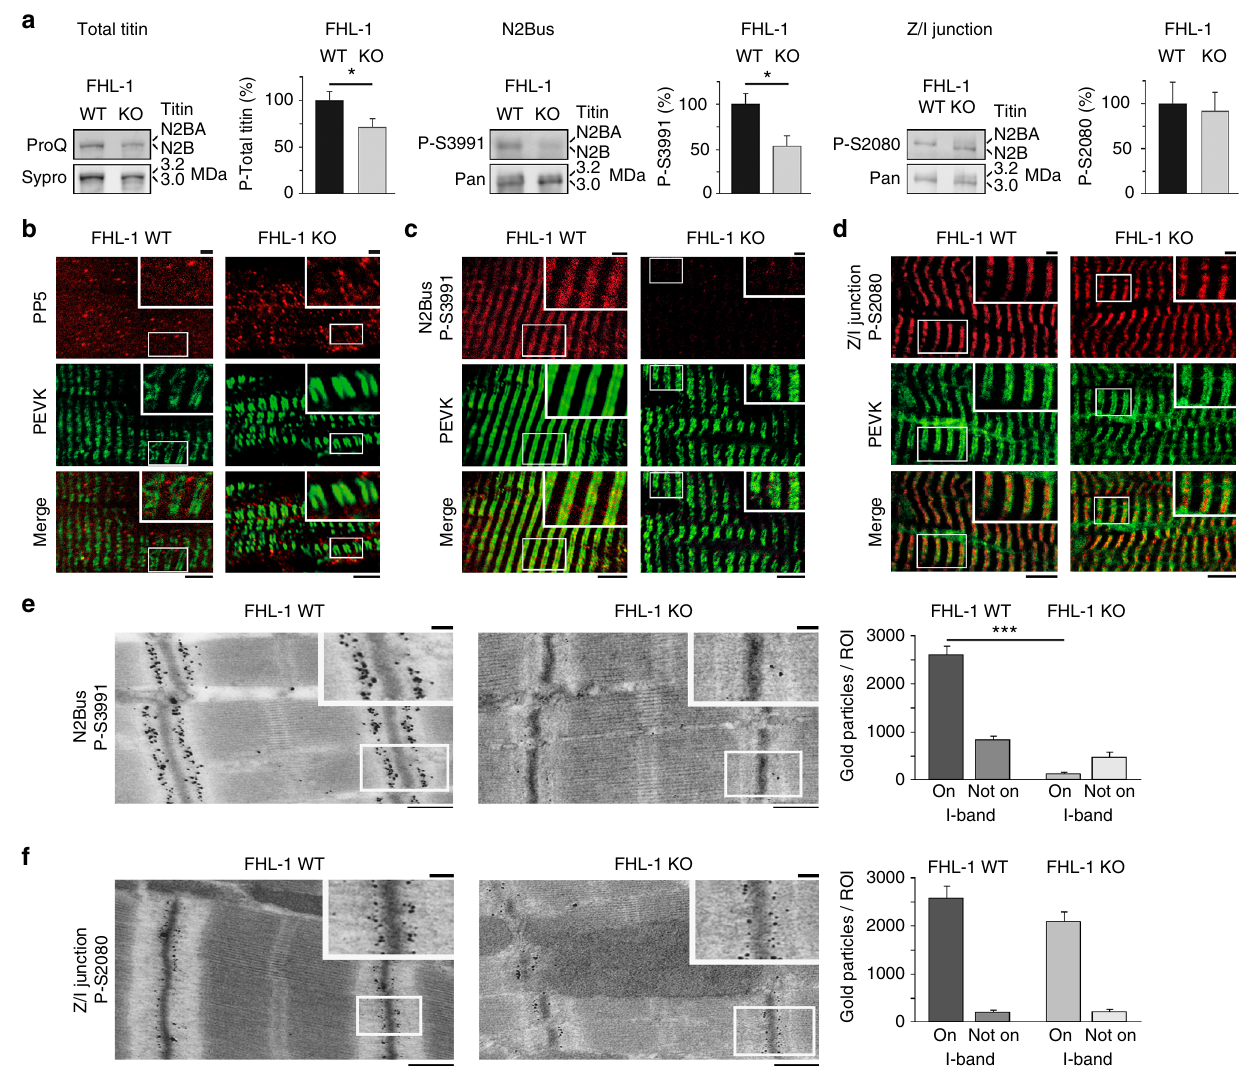
Fig. 7 Reduced N2Bus phosphorylation in FHL-1-de fi cient cardiomyocytes. a Total titin phosphorylation measured by ProQ Diamond/Sypro Ruby staining (left) and site-speci fi c titin phosphorylation detected by western blot using antibodies to P-S3991 (N2Bus; middle) or P-S2080 (Z/I junction; right). Site- speci fi c titin phosphorylation levels were normalized to total titin levels detected by WB using sequence-speci fi c antibodies (Pan). Means were indexed to those of control (WT) groups. Data are mean ± s.e.m., n = 3 hearts/group, samples analyzed in triplicate; * p < 0.05, by two-tailed Student ’ s t -test. b , c , d Localization of PP5 ( b ), phospho-N2Bus P-S3991 ( c ), and phospho-Z/I-junction P-S2080 ( d ) in cardiomyocytes from FHL-1 WT and KO hearts by indirect immuno fl uorescence. Anti-PP5, anti-N2Bus P-S3991 or anti-Z/I-junction P-S2080 (secondary antibody: Cy3-conjugated IgG), counterstained with anti-PEVK antibody (secondary antibody: FITC-conjugated IgG). Bars, 5 µ m (main) and 1 µ m (insets). e , f Sarcomeric localization of phospho-N2Bus P-S3991 ( e ) and phospho-Z/I-junction P-S2080 ( f ) in FHL-1 WT and KO hearts by immunogold electron microscopy. Bars, 500 nm (main) and 100 nm (insets). Bar graph in e and f shows average number of gold particles counted in 50- µ m 2 -sized regions-of-interest (ROI), either on the sarcomeric I-band or elsewhere in the cardiomyocyte ( ‘ Not on I-band ’ ). Data in e and f are mean ± s.e.m., n = 5 ROIs from two hearts/group. In a and e , * p < 0.05 and *** p < 0.001, by